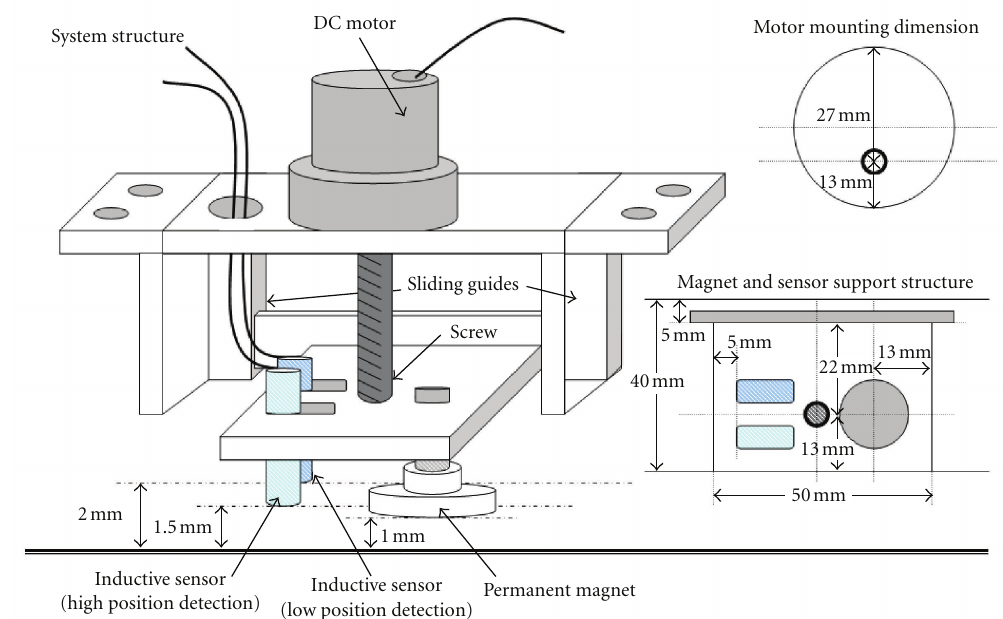
Figure 3: Scheme of the system for the dynamic adjustment of the distance between the permanent magnets and the surface of displacement.